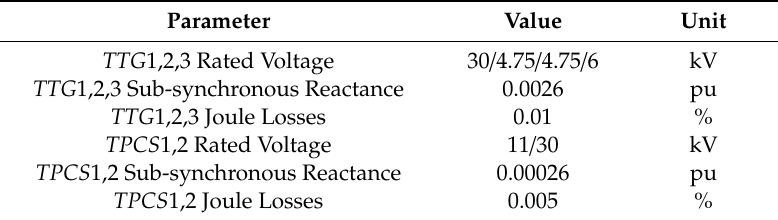
Table 8. Transformers electrical